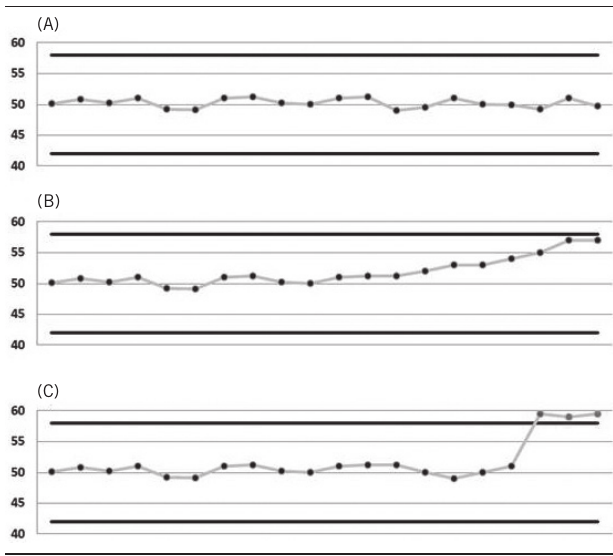
figuRE 1 − Levey-Jennings charts representing the daily assessment of an analyte with mean value and ranges defined by the product manufacturer (mean 50% ± 8%) A) chart with acceptable performance and values ranging around average; B) chart shows the trend in which the values progressively deviate from the mean. Corrective actions are required because more than eight consecutive values differ from the average; C) chart with values out of the acceptable upper limit. Corrective actions are required when three consecutive determinations present unacceptable performance, when there is a consecutive violation of two SD, when two SD are violated on the same day by two levels of control, and when a violation of three SD